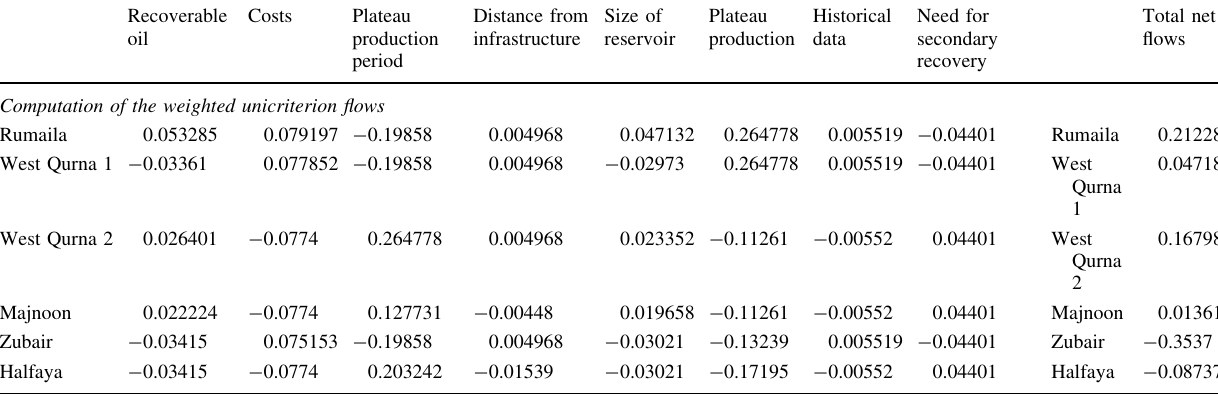
Table 10 PROMETHEE—global preference degrees Recoverable